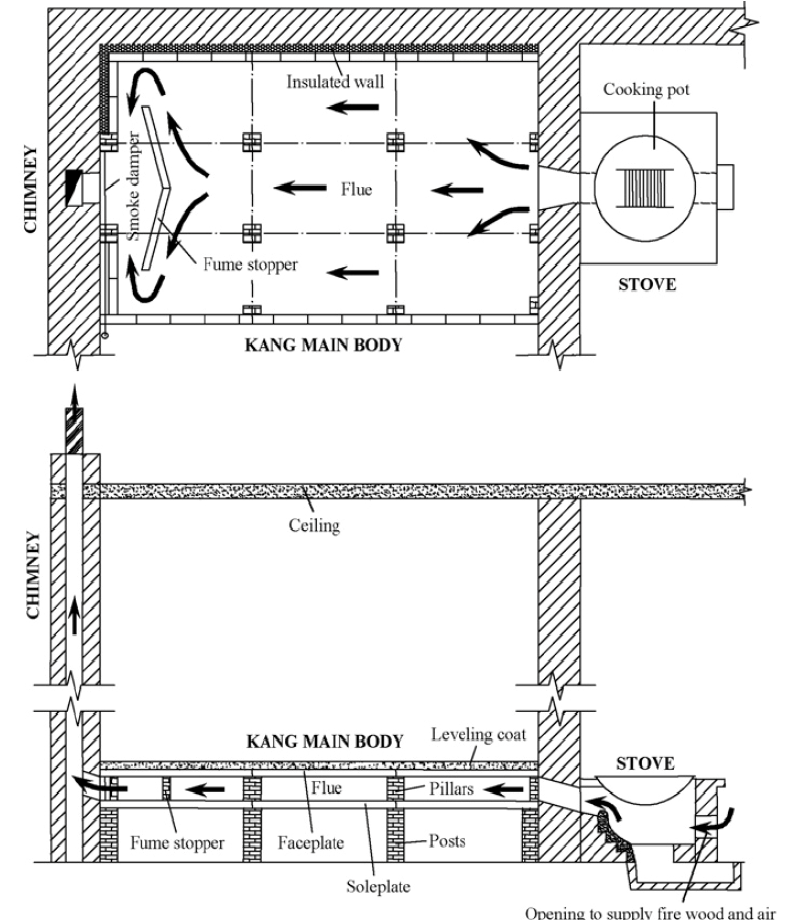
Figure 7. Plan and section of kang system